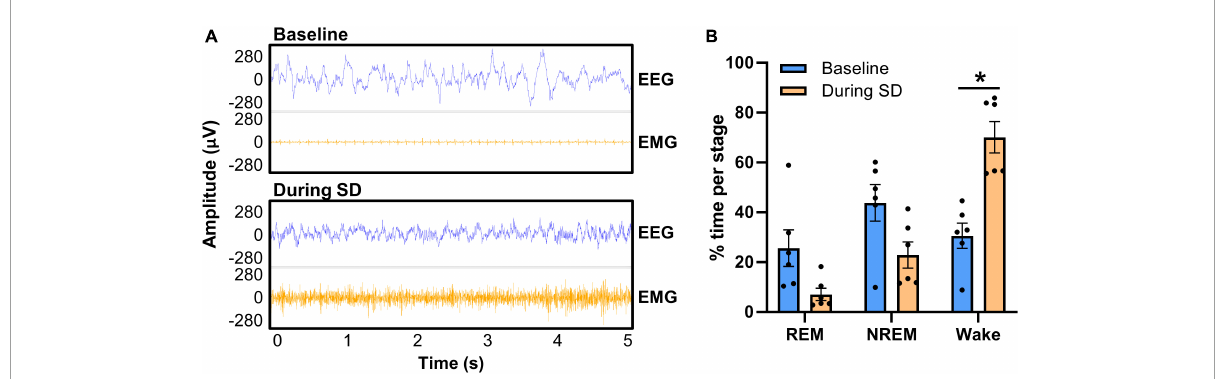
FIGURE7 Confirmation of PhenoTyper-mediated sleep disruption in EEG. Mice ( n = 6) underwent a baseline recording and an acute, 6-h sleep disruption (SD; 12–6 p.m.) 1 week later (refer to Figure 2 for timeline). SD involved an intermittent tone and light from the top-unit of the PhenoTyper so that each mouse was exposed to the same stimuli. The interval between both tone and light was procedurally randomized to prevent habituation. (A) Neuronal activity was recorded by EEG/EMG headcaps during SD and resembles wakefulness, with higher frequency EEG and EMG than sleep (baseline). Heartbeat can be detected in EMG when the mice are at rest [as in the baseline EMG in panel (A) ], but is not always present. (B) EEG/EMG data was staged as NREM, REM, and wake in the same time frame at baseline and SD, demonstrating a reduction in the time spent asleep and a significant increase in wakefulness ( P = 0.022). Data are mean ± SEM. Multiple paired t -tests with multiple comparisons were controlled for with the Holm–Šídák method. * P <